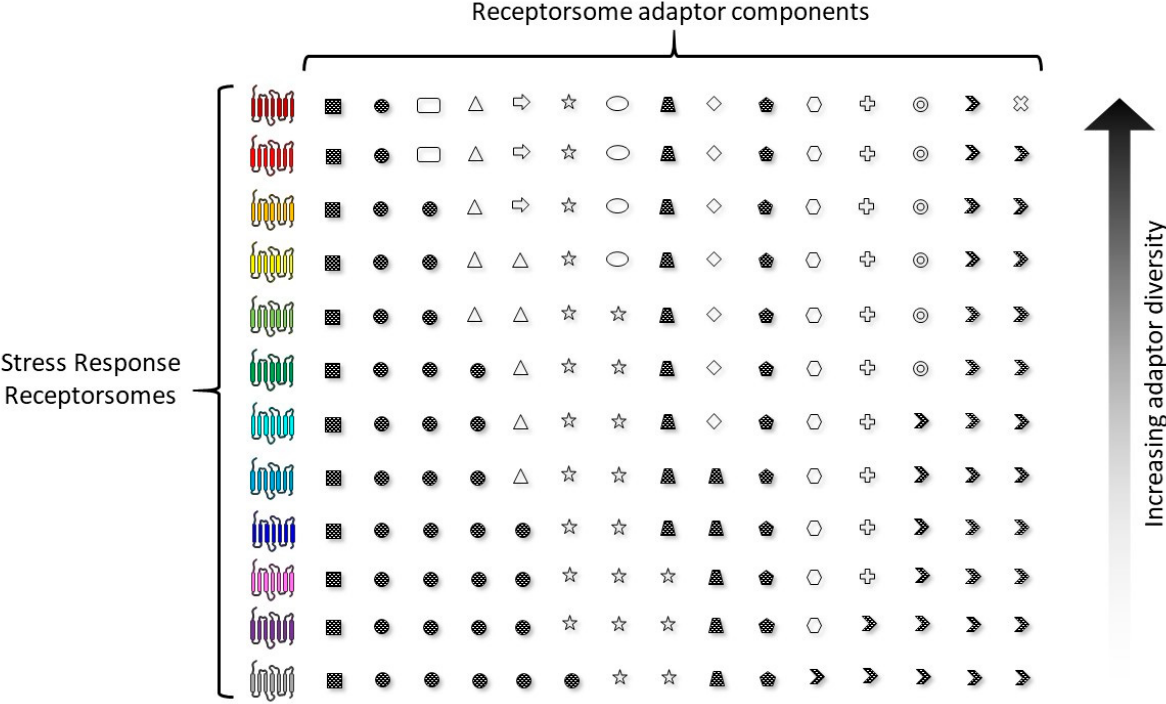
Figure 1. Diversity of the stress response receptorsome compositions. Here, we consider the presence of 12 hypothetical intracellular stress responsive GPCR receptorsomes (color-coded). These receptorsomes can be classified by their adaptor protein compositions. Some receptorsomes (scarlet and red) may comprise a broad variety of adaptors and, therefore, confer cellular resilience to a wide range of stressful perturbagens. Other receptorsomes (purple and grey) may consist of a smaller range of adaptors, thus reducing their potential to sense or contend with a wide range of cellular stressors. It is also noteworthy that it is likely that some receptorsome components are near-ubiquitous for all receptorsomes (e.g., square and circle); thus, these factors possess a higher trophic role in controlling multiple dimensions of stress sensation and mitigation. The adaptor proteins that are found in all of the receptorsomes are denoted using a black hashed fill. The presence of these consistent factors demonstrates that some GPCR adaptors can also function as intra-network communication factors across the diverse receptorsomes. Hence, the expression of such factors will likely serve as a network regulator function through common sensing of the receptorsome ensemble status.